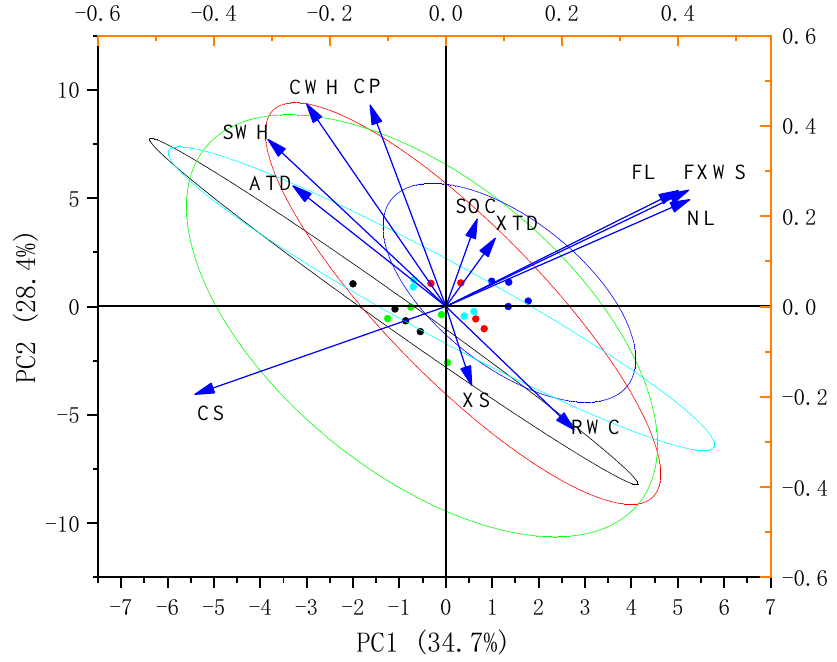
Figure 10. Principal component analysis of soil indexes under different treatments.